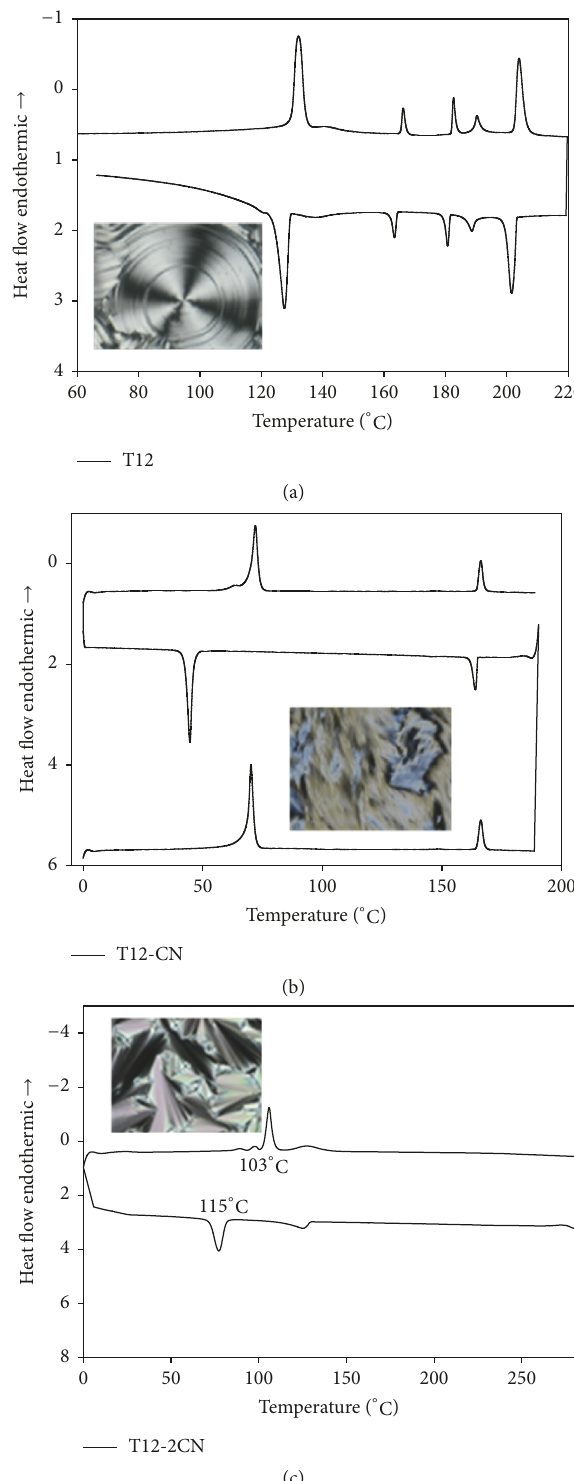
Figure 4: DSC thermograms of the terphenyls. The inset shows a POM texture. Micrographs temperatures are as follows: T12, 68 ∘ C, T12-CN, 89 ∘ C, and T12-2CN, 108 ∘